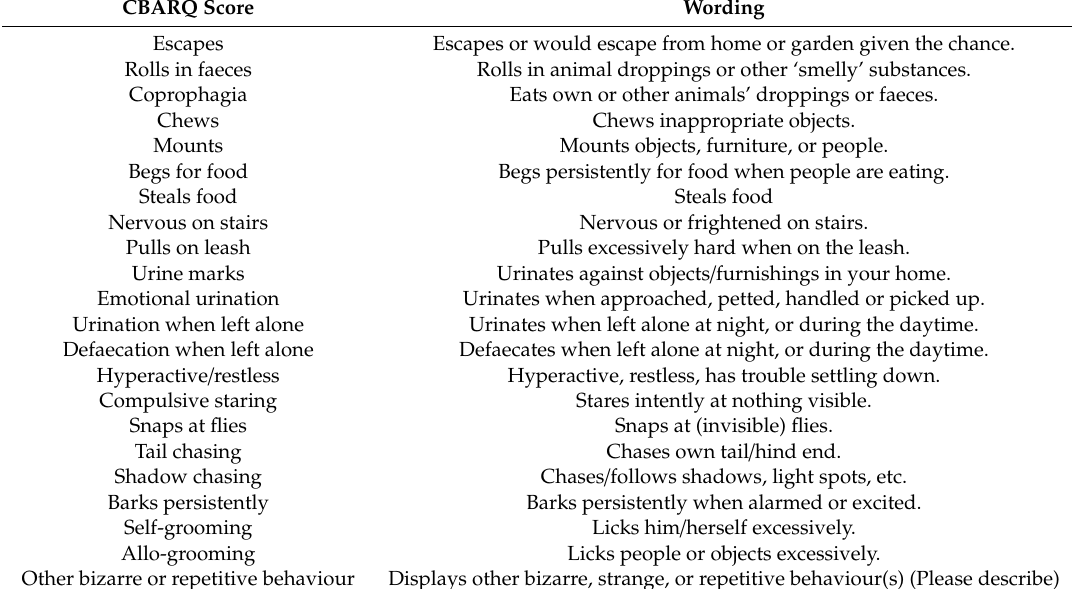
Table 1. The 22 miscellaneous items from the canine behaviour and research questionnaire (C-BARQ) (scored as frequency